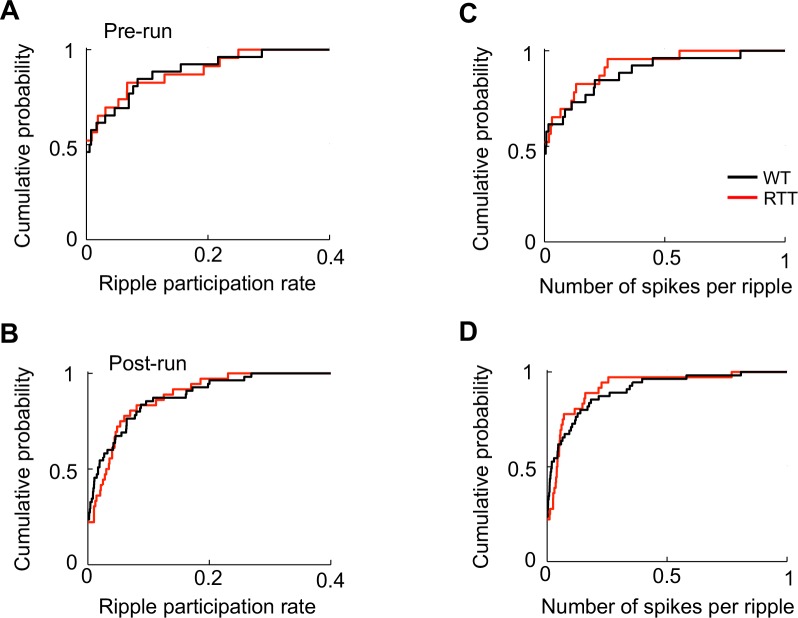
Activities of run-inactive cells within ripples did not differ between WT and RTT mice.(A – D) Cumulative distributions of ripple participation rate and number of spike per ripple for run-inactive cells in WT and RTT mice during Pre- and Post-run. Cells in Pre-/Post-run sessions before/after running the novel and familiar track are combined. (A): N = 26 (WT), 23 (RTT); p=0.81, Wilcoxon ranksum test. (B): N = 55 (WT), 36 (RTT); p=0.58. (C): N = 26 (WT), 23 (RTT); p=0.74. (D): N = 55 (WT), 36 (RTT); p=0.68. There was no significant difference between Run-run and Post-run in any of the parameters in either WT or RTT mice (p>0.55).